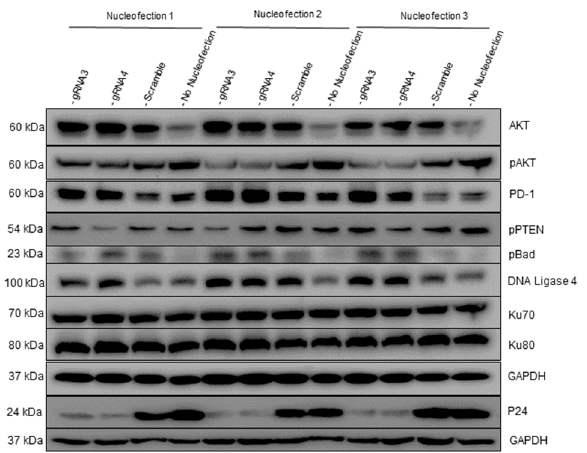
Figure 5. Cell activation, apoptosis, and DNA damage repair molecules in J1.1 cells treated with gRNA-3 RNP or gRNA-4 RNP. Representative Western blots showing AKT, pAKT Ser473 , PD-1, pPTEN Ser370 , pBad Ser112 , DNA ligase 4, Ku70, Ku80, P24, and GAPDH proteins in J1.1 cells after PMA stimulation, followed by the transfection using gRNA-3, gRNA-4, or scramble gRNA RNP. Nucleofection 1, 2, and 3 represent three independent experiments. For no nucleofection samples (last lane), non-transfected J1.1 cells were stimulated with PMA.